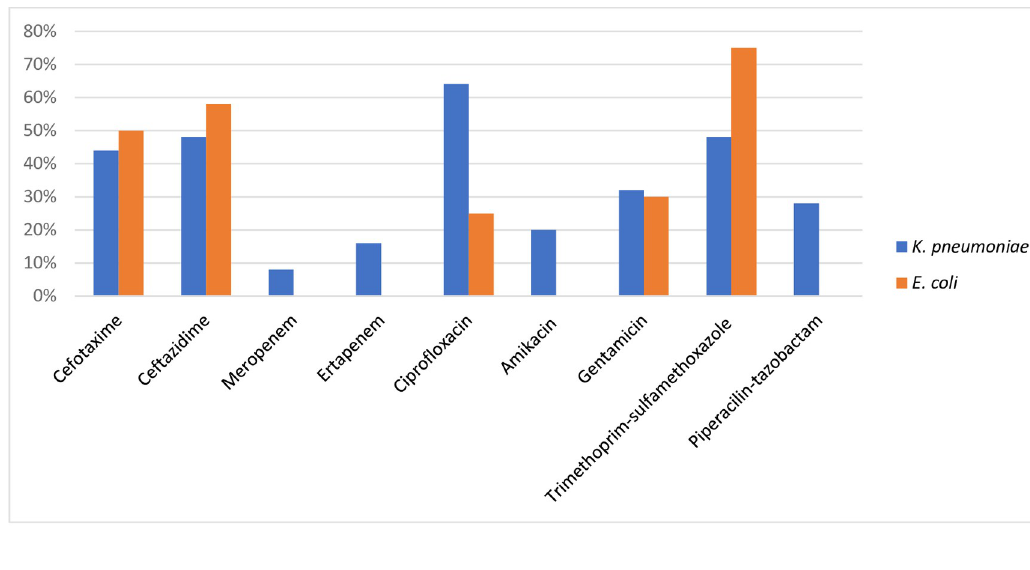
Fig 1. Antimicrobial susceptibility pattern for E . coli (n = 12 ) and K . pneumoniae (25) isolates on selective ESBL Chromagar and tested against commonly prescribed antibiotics.